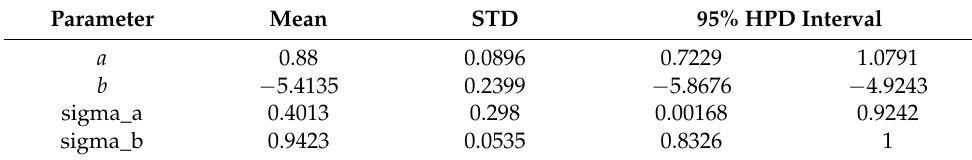
Table 4. Posterior parameters for the Bayesian approach.